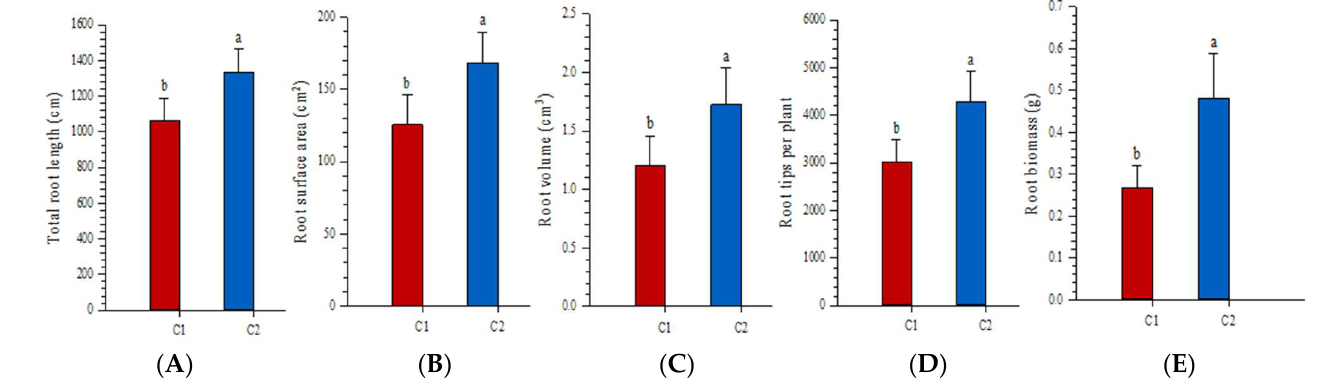
Figure 3. Effects of fragment size on total root length ( A ), root surface area ( B ), root volume ( C ), root tips ( D ) and root biomass ( E ). Bars with the same letters were not significantly different ( p > 0.05) using Tukey’s test. Error bars indicate standard error of means. C1 = individual with single ramet, C2 = individual with three ramets. Table 5. The one-way analysis of variance (ANOVA) of the effects of nitrogen addition, phosphorus addition and water addition on root biomass, total root length, root surface area, root volume, root tips and specific root length under each level of fragment size for Stipa breviflora.